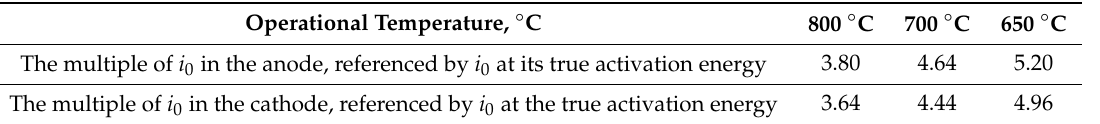
Table 5. The calculated reference exchange current density i 0 versus the change of the activation energy (by 10% decrease of the activation energy).